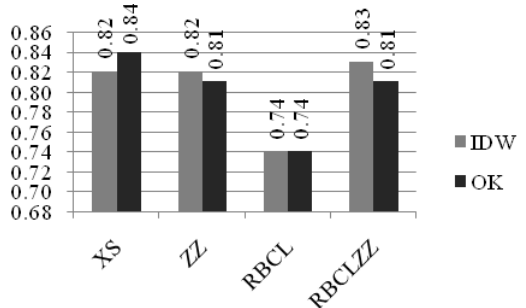
Figure 10. F values of the simulated maximum flood extent.